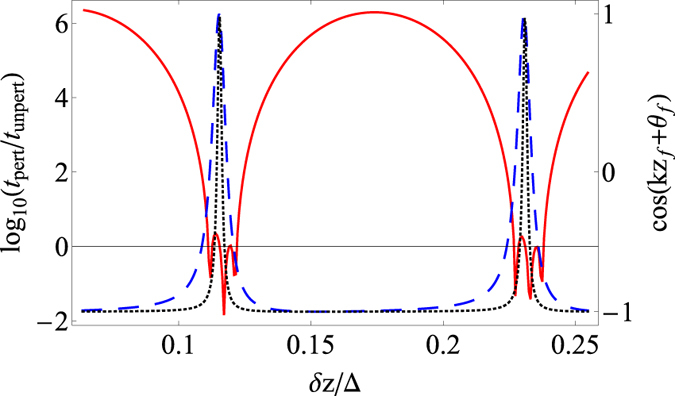
Instability region.The dependence of the ratio (logarithmic scale) of the transmission coefficient t = (|u1(L)|2 + |u2(L)|2)/(|u1(0)|2 + |u2(0)|2) of perturbed tpert to unperturbed tunpert systems on the perturbation length δz (red solid line) and the dependence of the value cos(kzf + θf) after perturbation on the perturbation length δz (blue dashed line). For both lines (red and blue) |κ|2 = 1.01g2, u1(0) = u2(0). Black dotted line: the dependence of the value cos(kzf + θf) after perturbation on the perturbation length δz, in the case of |κ|2 = 1.001g2. The EP corresponds to the case when |κ|2 = g2. Other parameters are the same as in Fig. 3.